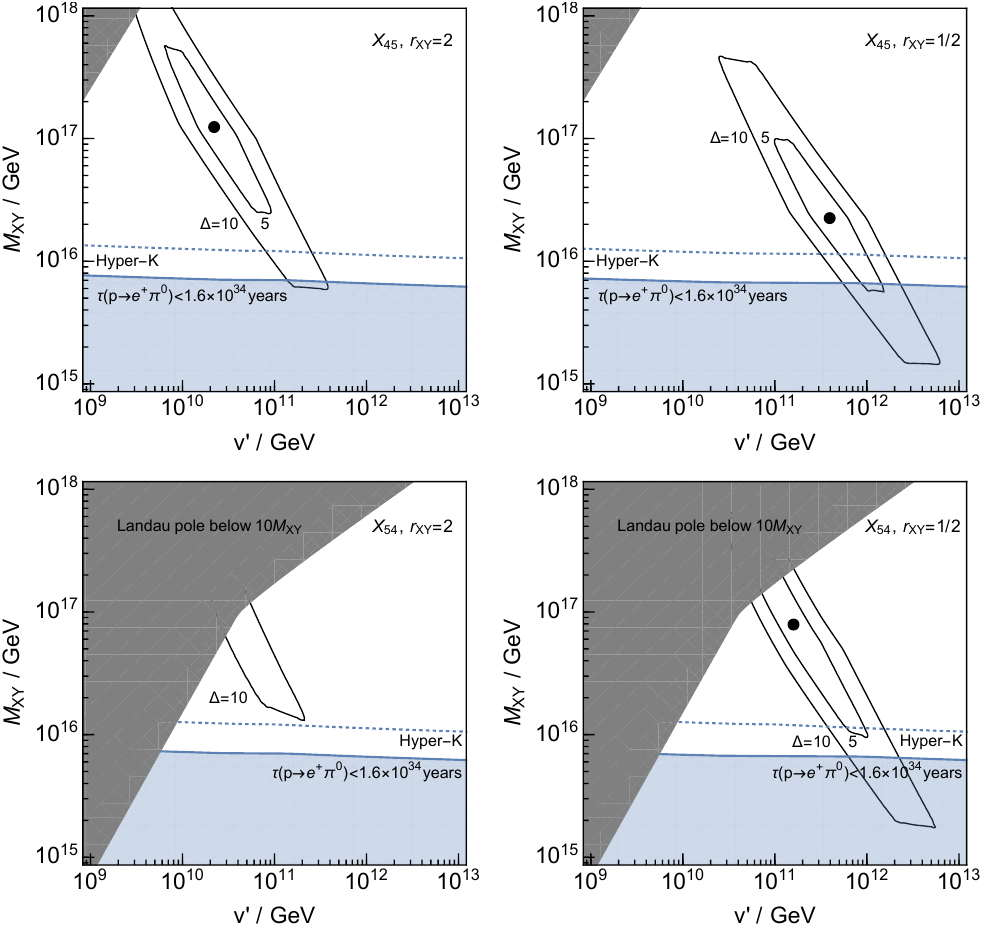
Figure 3 . Determination of v 0 and M XY in the 3221 theory from gauge coupling uni(cid:12)cation alone. The left (right) panels are for di(cid:11)ering values of the uni(cid:12)ed gauge threshold corrections, and the contours show the e(cid:11)ects of uni(cid:12)ed threshold corrections from scalars and fermions. The upper (lower) panels have the top yukawa coupling generated from the exchange of a 45 ( 54 ) X state. a dimension (cid:12)ve operator typically give (cid:1) 10 for a uni(cid:12)cation scale of 10 17 GeV. ’